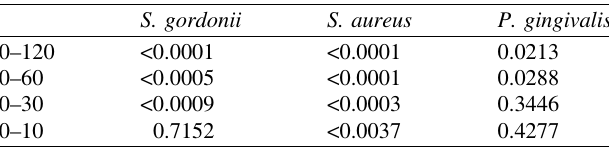
Table 2. Statistical analysis of the effect of Tenex sonication on various bacteria and various